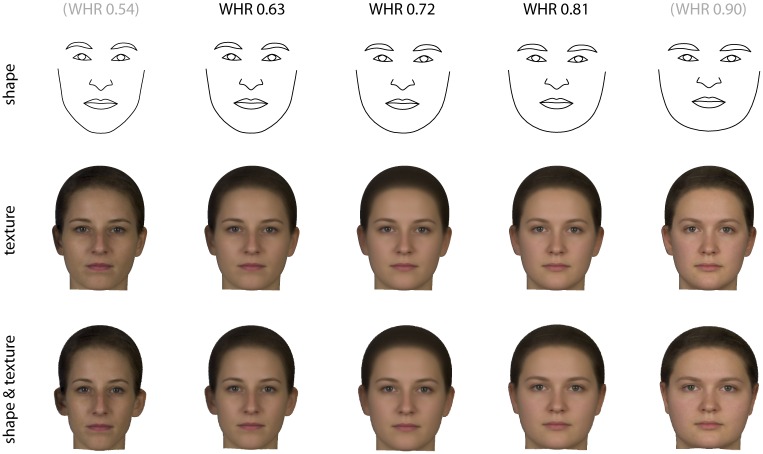
Regressions of shape (upper panel), texture (middle panel), as well as both together (lower panel) on waist-to-hip ratio (WHR).The reconstructed faces represent the average shapes and textures predicted for WHR 0.63, 0.72, and 0.81, respectively, based on these regressions. These are ±2 standard deviations around the average WHR of 0.72 and approximately represent the limits of variation observed in our sample. The left-most and right-most faces in the figure are twofold extrapolations of this range; the correspond to deviations of ±4 standard deviations from the mean and to (hypothetical) WHRs of 0.54 and 0.90.